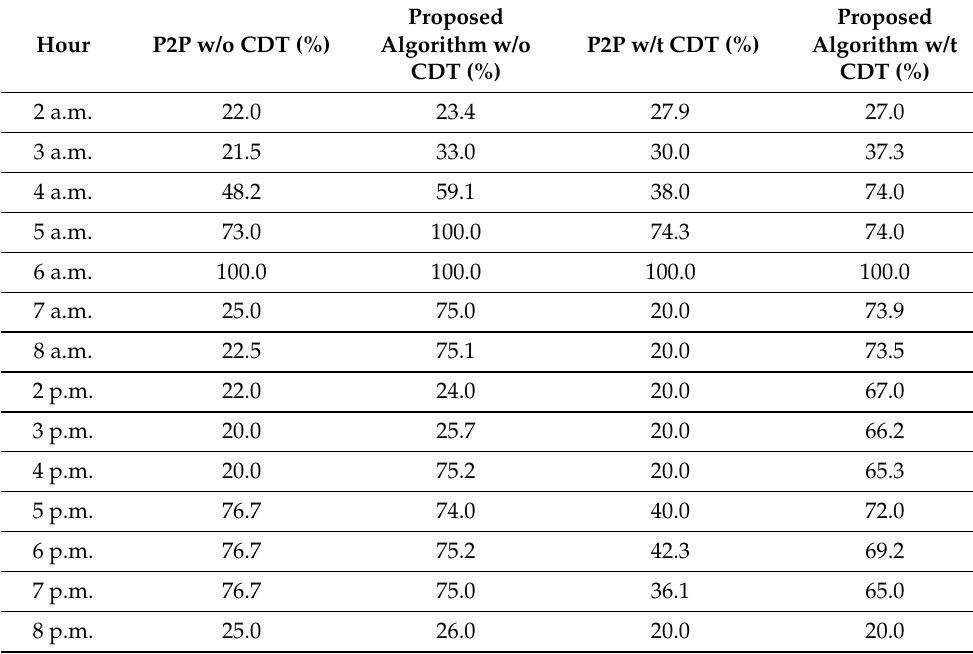
Figure 8. Total cost vs. probability of generation stochasticity violation Table 3. Batteries state of